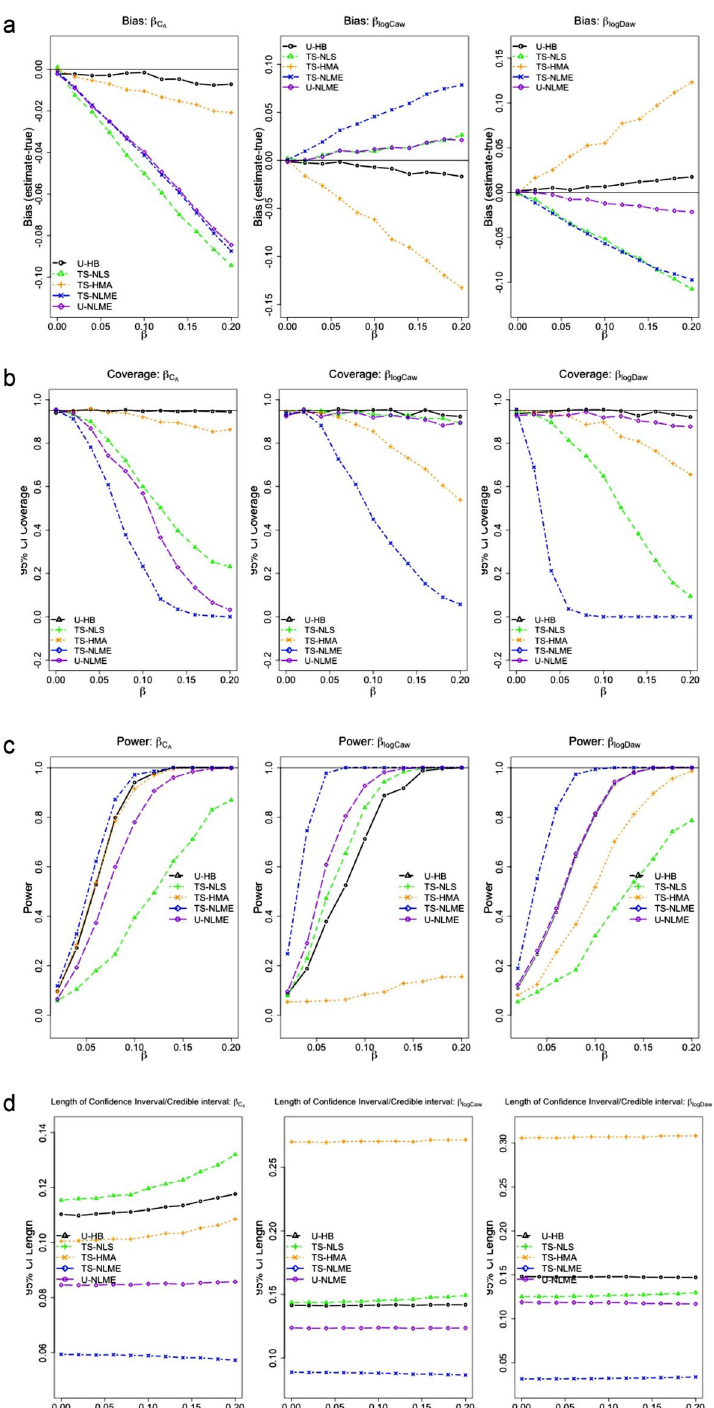
Figure 2. Relative bias ( a ), coverage ( b ), power ( c ) and CI length ( d ) of the selected estimation methods from Scenario 1 of the simulation study ( β C